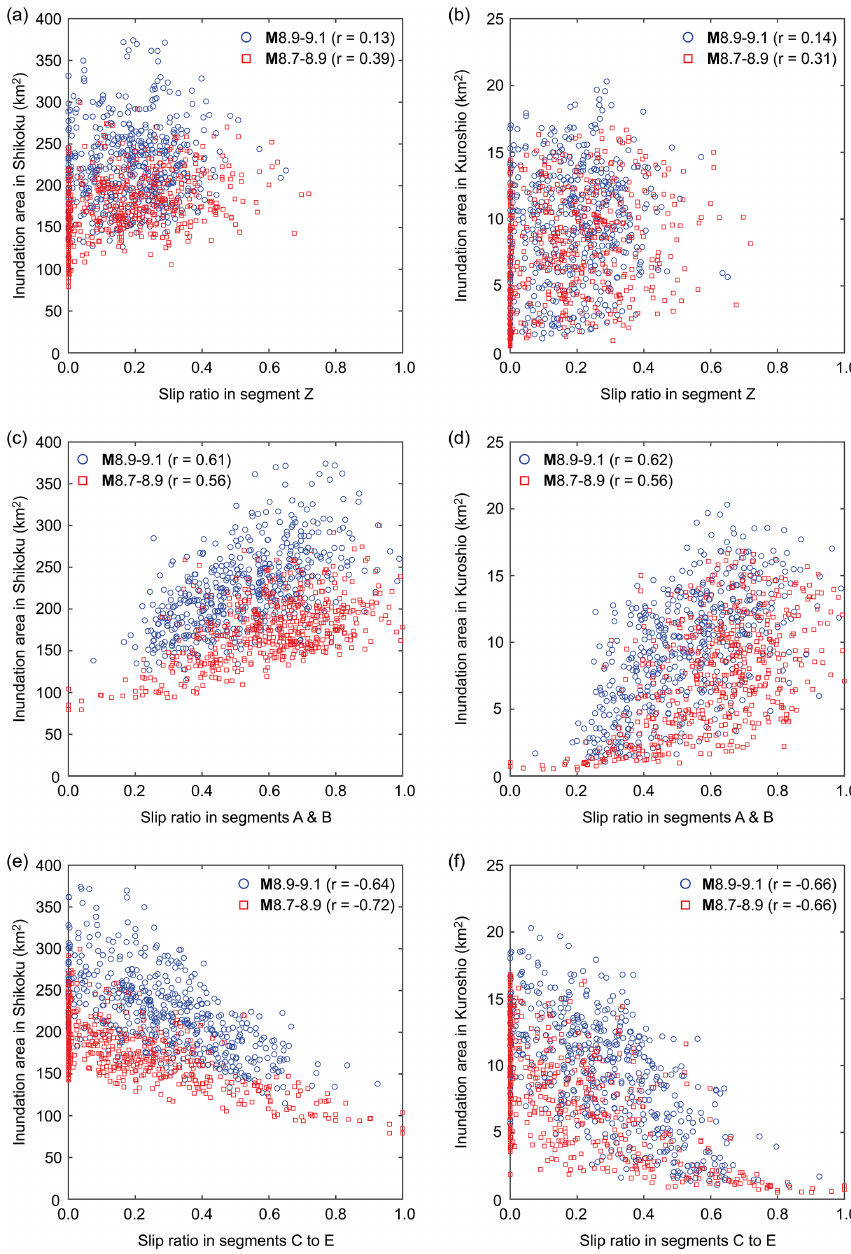
Figure 9. Scatter plots of slip ratios in segments Z (Hyuga-nada), A–B (Nankai), and C–E (Tonankai–Tokai) versus tsunami inundation areas in Shikoku (a, c, e) and Kuroshio (b, d, f) for the two magnitude ranges M 8.9–9.1 and M 8.7–8.9.